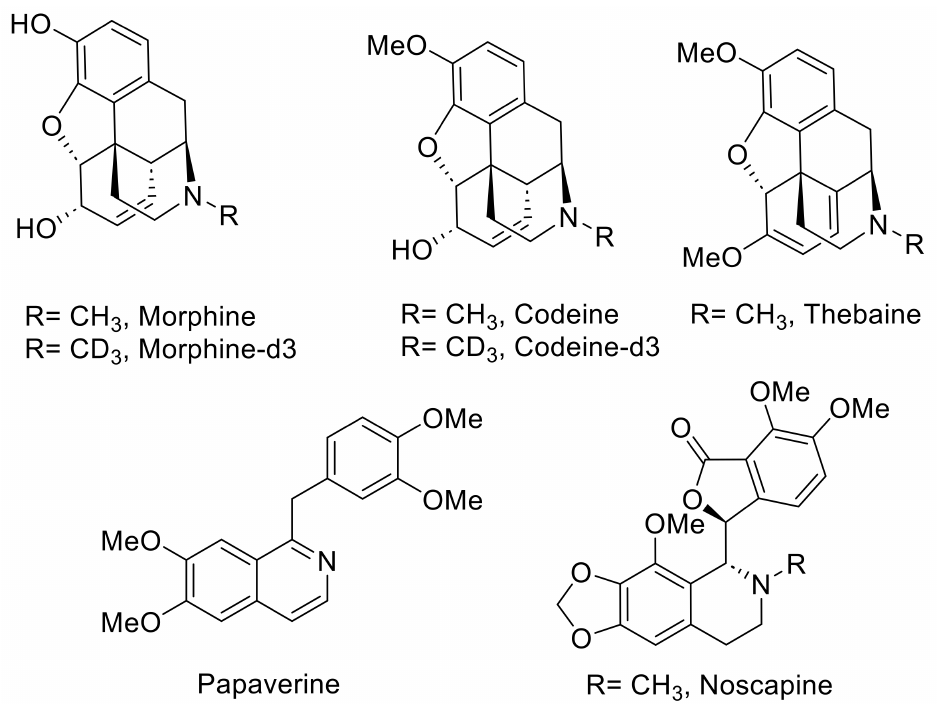
Figure 2. Chemical structures of five alkaloids and two internal standards, morphine-d 3, and codeine-d 3